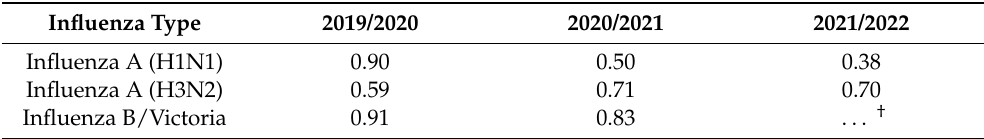
Table 2. Spearman’s correlation coefficients comparing the antibody titers in other seasons with those